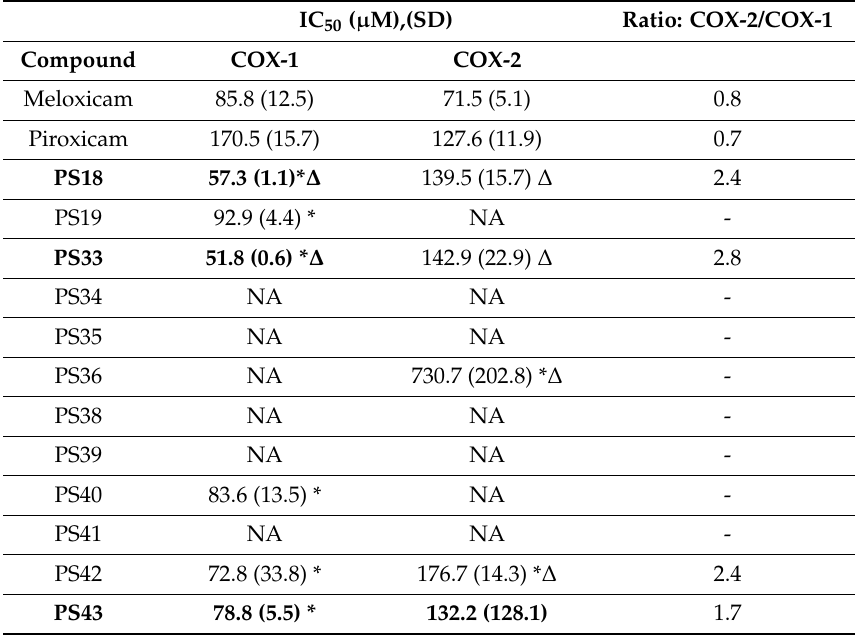
Table 1. COX-1 and COX-2 IC 50 (SD) values for the studied compounds as compared with piroxicam and meloxicam (mean (SD); n =